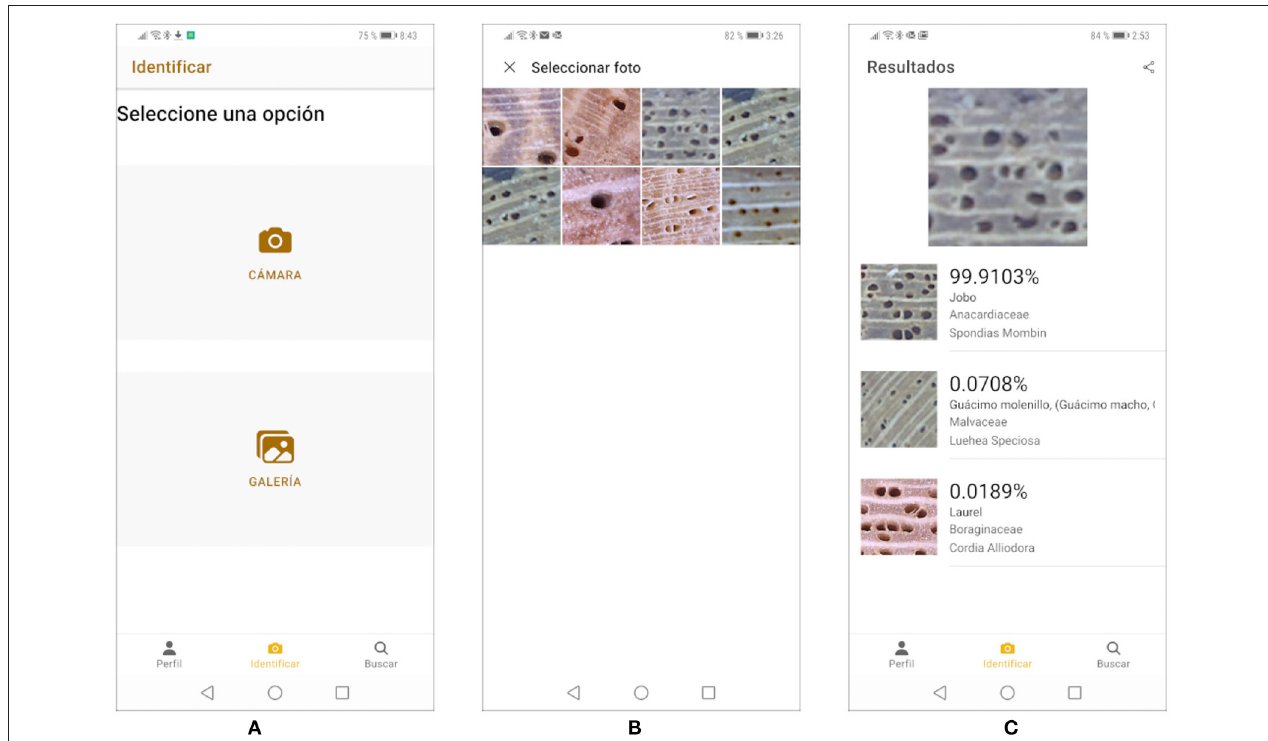
FIGURE 11 | (A–C) COCOBOLO mobil